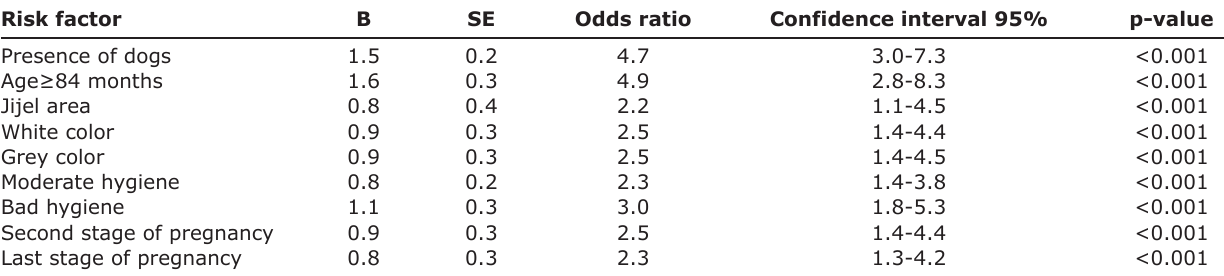
Table-2: Risk factors (logistic regression final model) associated with Neospora caninum seropositivity in pregnant local cows from North-Eastern Algeria. Risk factor B SE Odds ratio Confidence interval 95% p-value Presence of